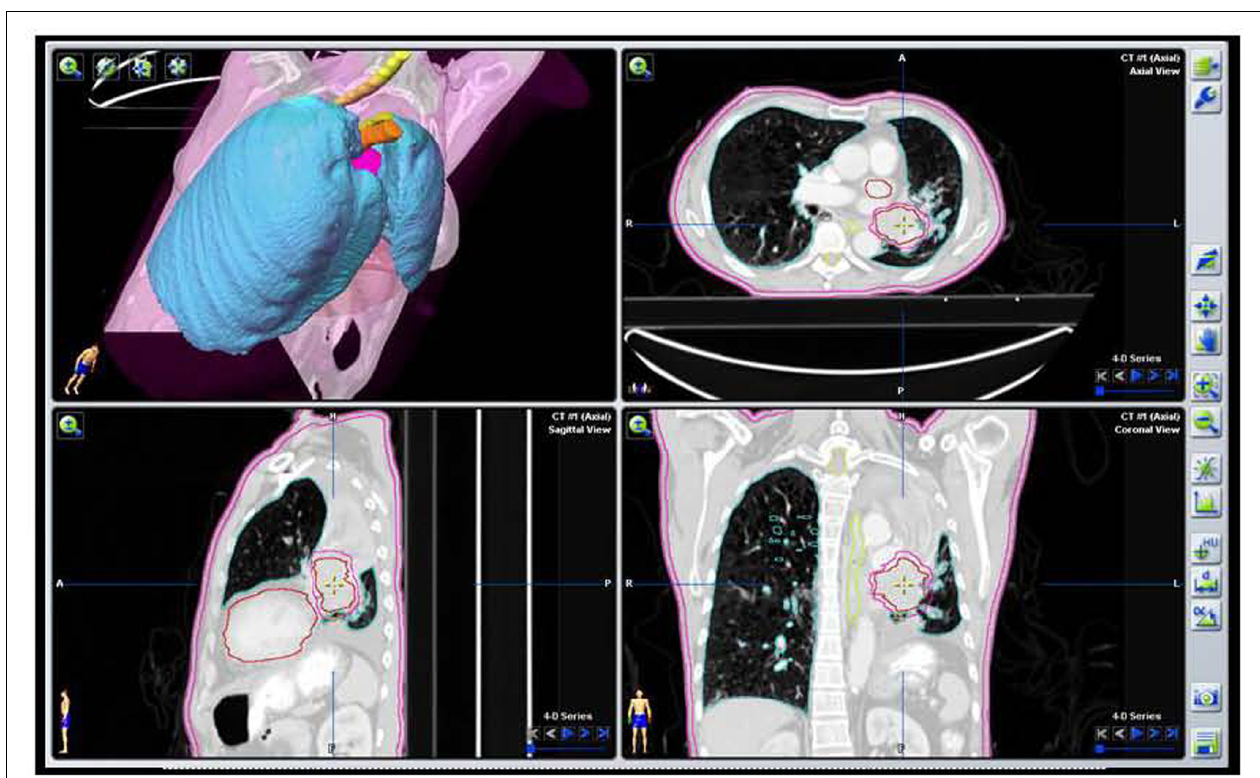
FIGURE 5 |Target volume contours of the same patient as Figure 2A based on the initial PET/CT data withVOI defining the GTV and PTV excluding collapsed lung